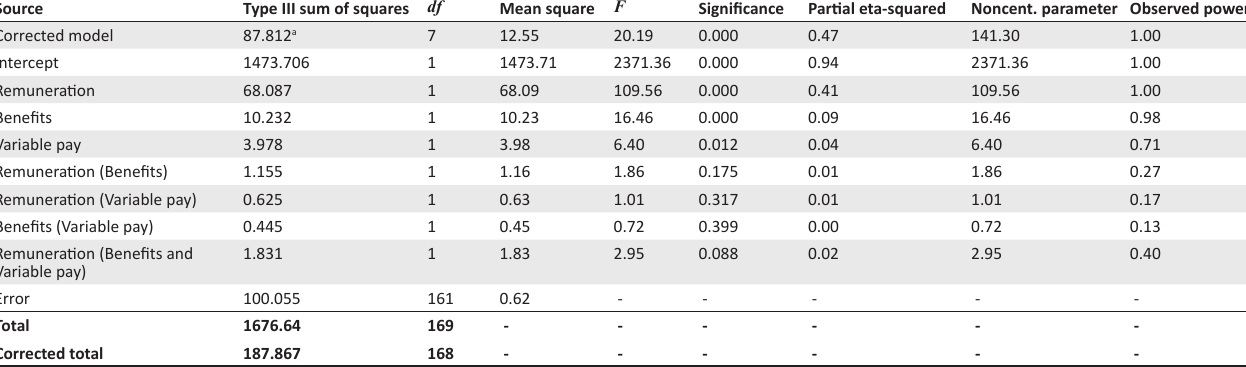
TABLE 6: Results of full-factorial analysis of variance showing the impact of financial rewards on job